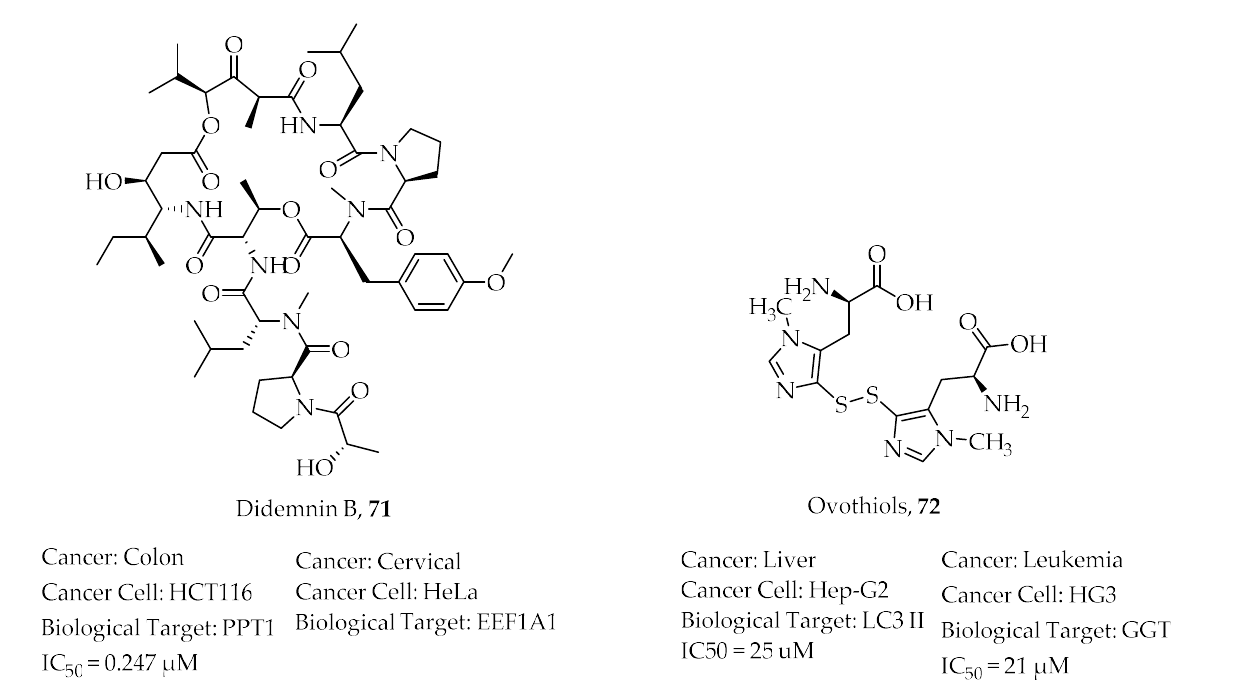
Figure 8. Chemical structures of Didemnin B, 71 and Ovothiols, 72 with a summary of their biological activity towards selected targets.